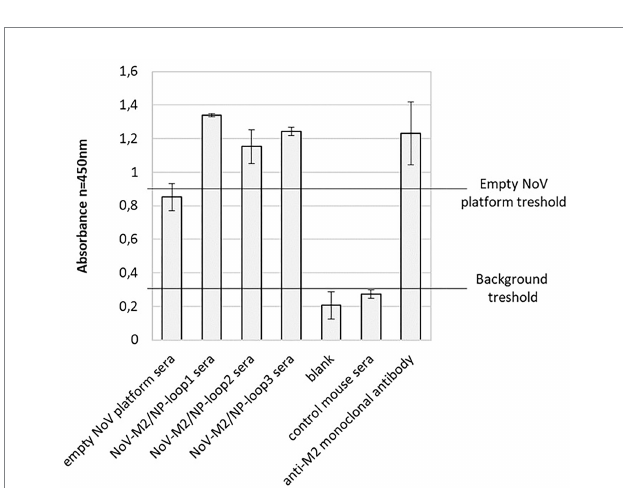
FIGURE 5 Reactivity of mouse sera collected after immunization with chimeric NoV-M2/NP VLPs by ELISA. An ELISA plate was coated with M2 antigen-presenting VLPs (NoV VLP with M2/NP epitope in all three loops). Pooled sera from immunized mice showed good reactivity with the M2 antigen, as well as to the NoV platform. The bars represent the mean values obtained from triplicate experiments. The mean A450 values and standard deviations are shown on the